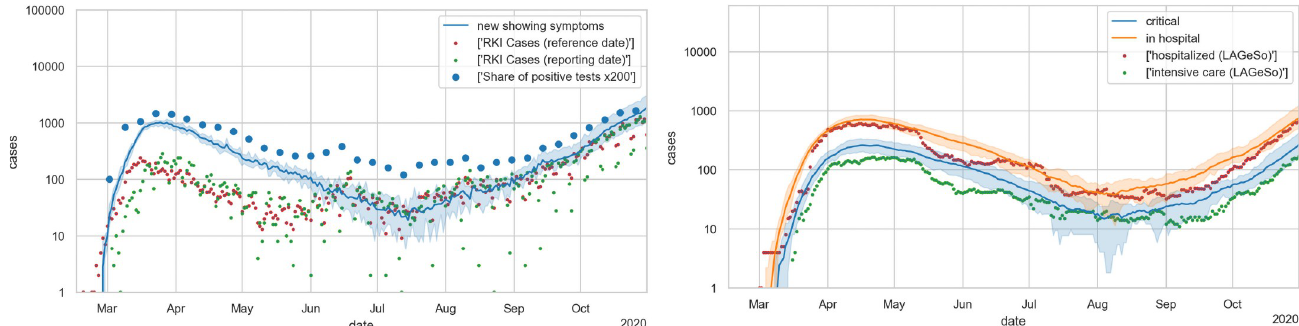
Fig 12. Final model. LEFT: new cases; RIGHT: hospital occupancies. All simulation results are averaged over 10 runs with different Monte Carlo seeds; the shaded areas denote 5% and 95% percentiles of those 10 runs. Evidently, the relative errors become larger with smaller case numbers. The simulation model can only be fitted against the hospital numbers (right) when significant under-reporting is assumed in the early phase